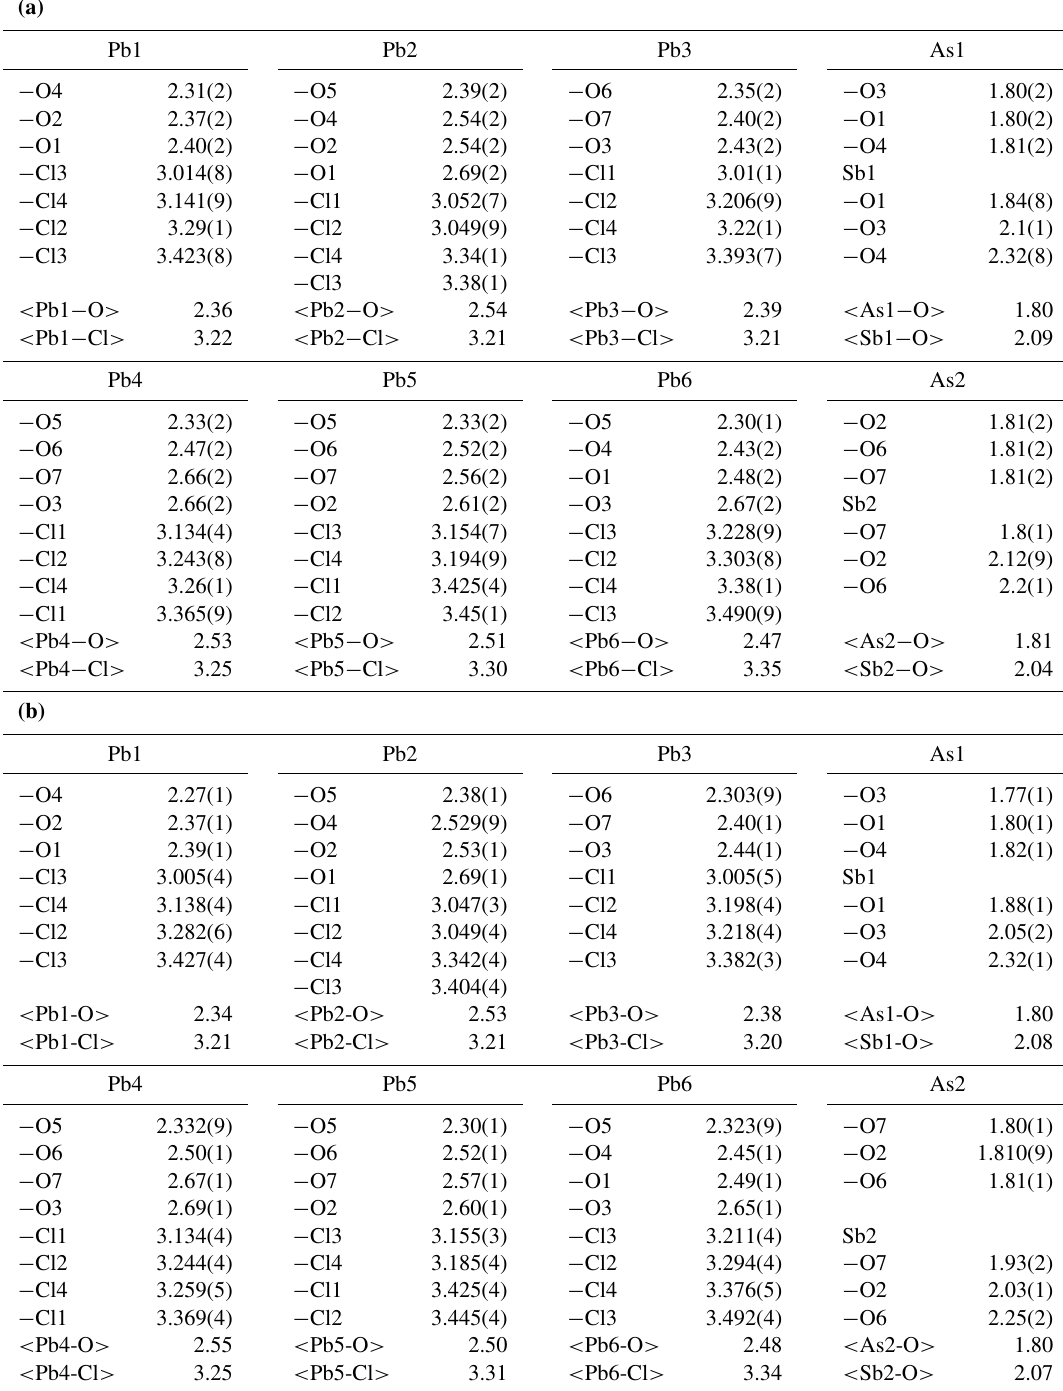
Table 5. (a) Selected bond distances (Å) for heliophyllite. Bond lengths < 3 . 5Å were taken into account for Pb coordination. (b) Selected bond distances (Å) for ecdemite (from Perchiazzi et al., 2019). Bond lengths < 3 . 5Å were taken into account for Pb